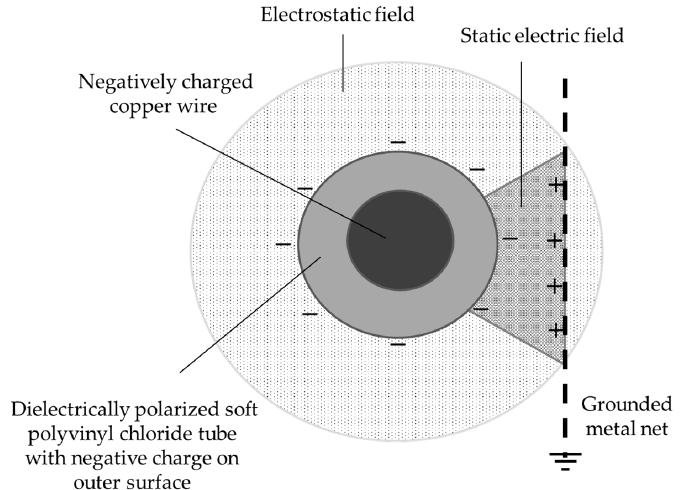
Figure 2. Formation of a static electric field inside the electrostatic field formed by a single-charged monopolar electric field screen (SM screen) (cross-sectional view).